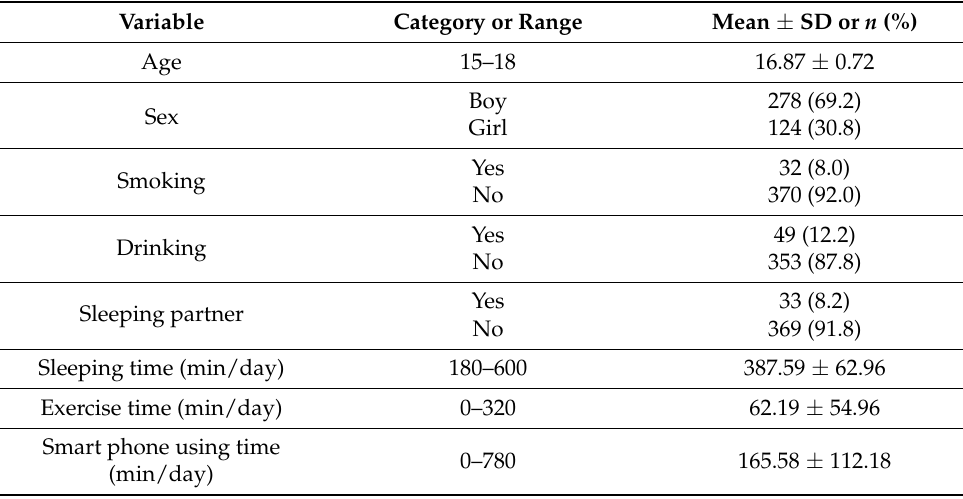
Table 1. Demographic characteristics ( n =